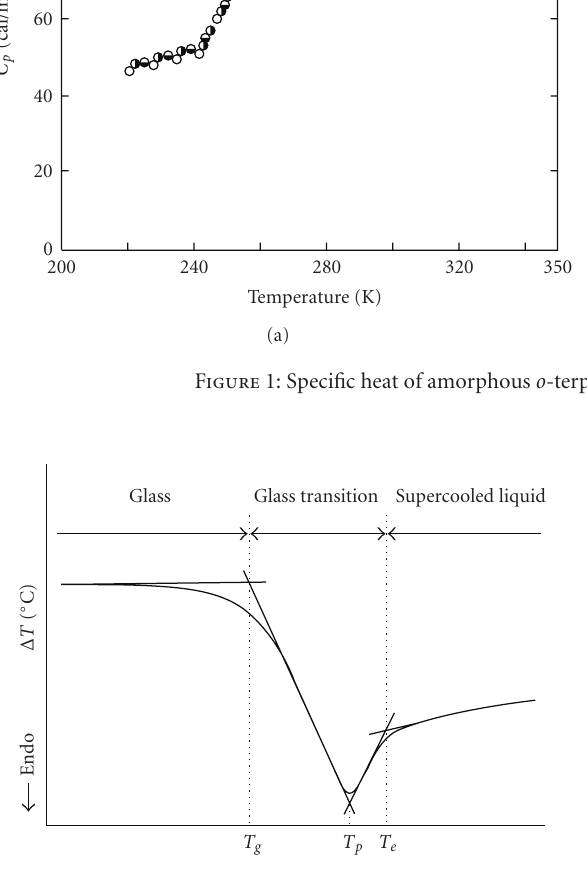
Figure 2: Determination of glass transition temperature T g based on di ff erential temperature analysis (DTA), below the T g the material is glassy whereas above the T e the material is liquid (after